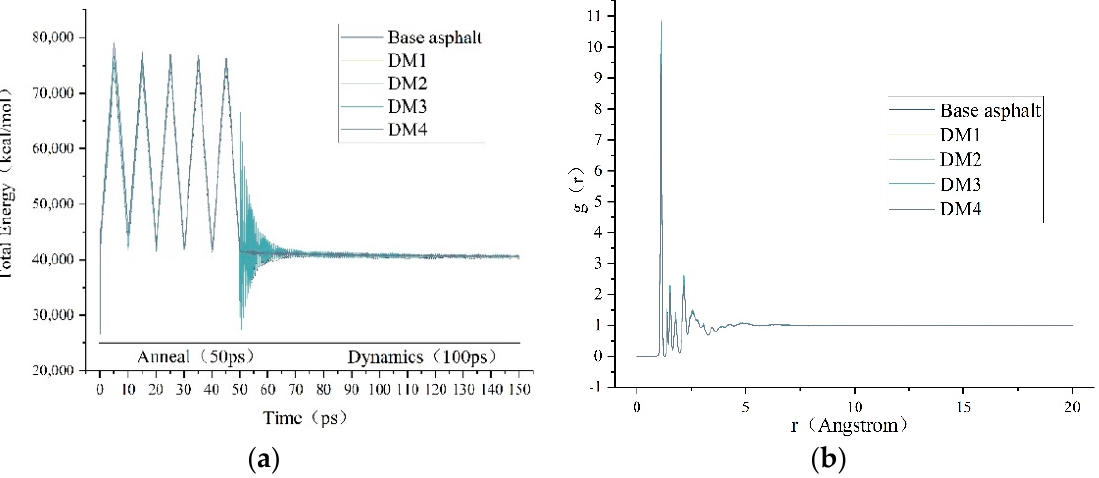
Figure 13. Model reasonableness verification. ( a ) Energy state of the model optimization process and ( b ) radial distribution function (RDF).